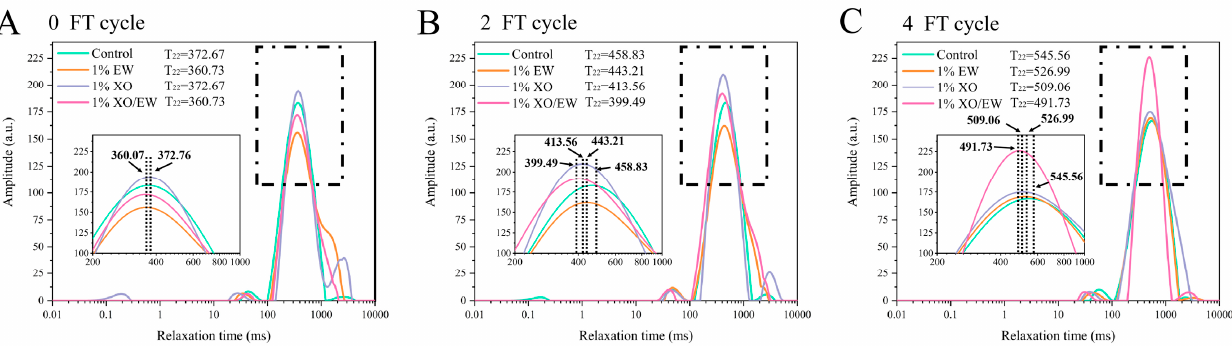
Fig.4 Changes of T 22 relaxation time in the heat-induced gel of Culter alburnus myofibrillar protein added with EW, XO or XO/EW after 0 (A),2 (B), and 4 (C) freeze-thaw cycles (mean±SD, n=3). The control group (Control) was not added with EW, XO or XO/EW. Capital letters indicate a significant difference (P < 0.05) between different freeze-thaw cycles within the same treatment group. Lowercase letters indicate a significant difference (P < 0.05) between different treatment groups in the same freeze-thaw cycle.